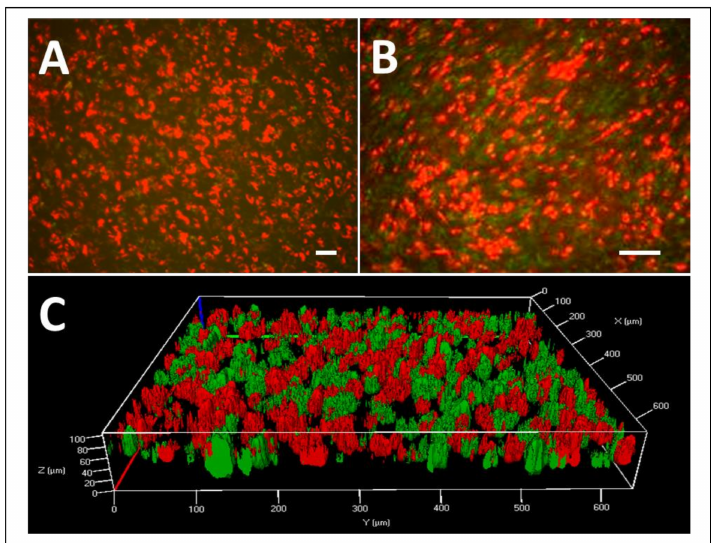
Figure 4. Differentiated endothelial cell attached to the smooth muscle sheet comprised of mes- enchymal stem cells from hair follicle outer root sheath (MSCORS-SM-Sheet). Demonstration of the MSCORS derived endothelial cells attached to the MSCORS-based MSCORS-SM-Sheet labeled with fluorescent dyes. MSCORS-differentiated endothelial cells were labeled with a red fluorescent dye (PKH26), and the MSCORS-based smooth muscle sheet was labeled with a green fluorescent dye (PKH67). ( A , B ) Fluorescence microscopy of the endothelial cells (red) attached and layered atop the MSCORS-SM-Sheet (green) (scale bar 100 µ m, magnification: ( A ) 10 × , ( B ) 20 × ). ( C ) 3D reconstruction of the endothelial cell + smooth muscle sheet using laser scanning confocal